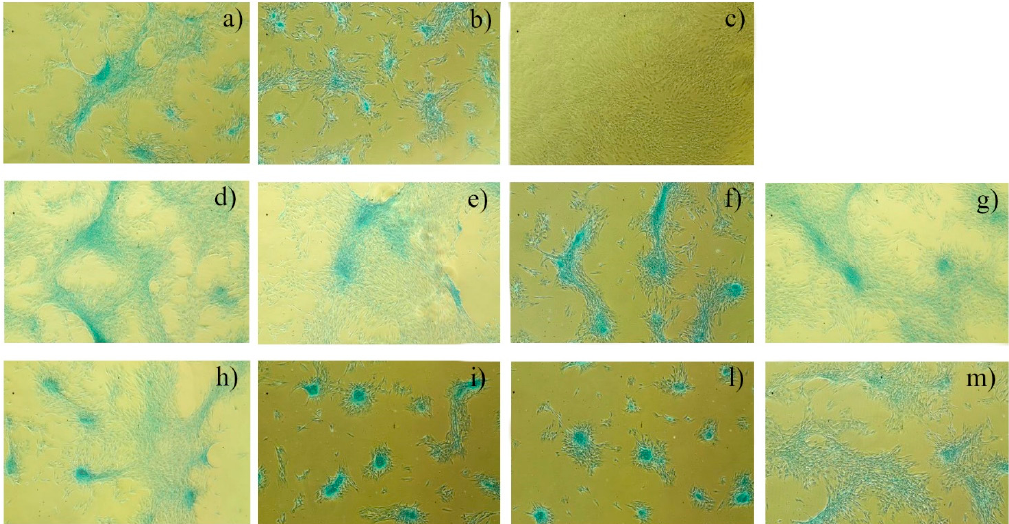
Figure 4. Capability of BMMSCs to differentiate, after three weeks of incubation, into